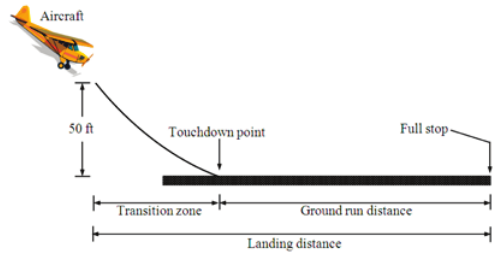
Fig. 4. Aircraft in approach phase of